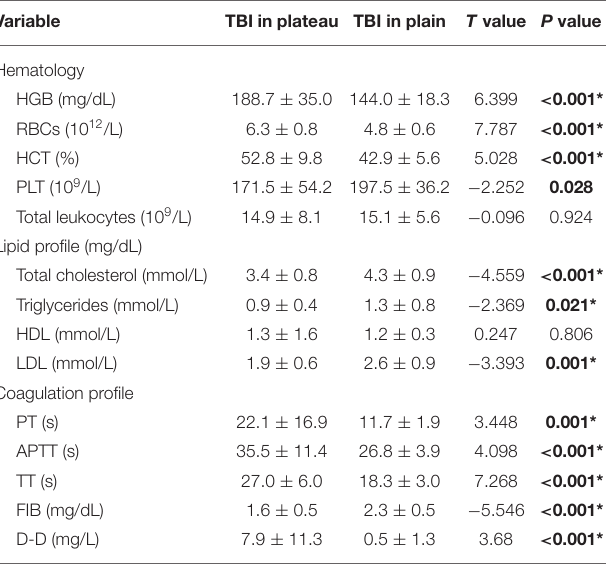
TABLE 5 | Correlation between coagulation parameters and RBCs indexes in patients with TBI. TBI in plateau areas TBI in plain areas